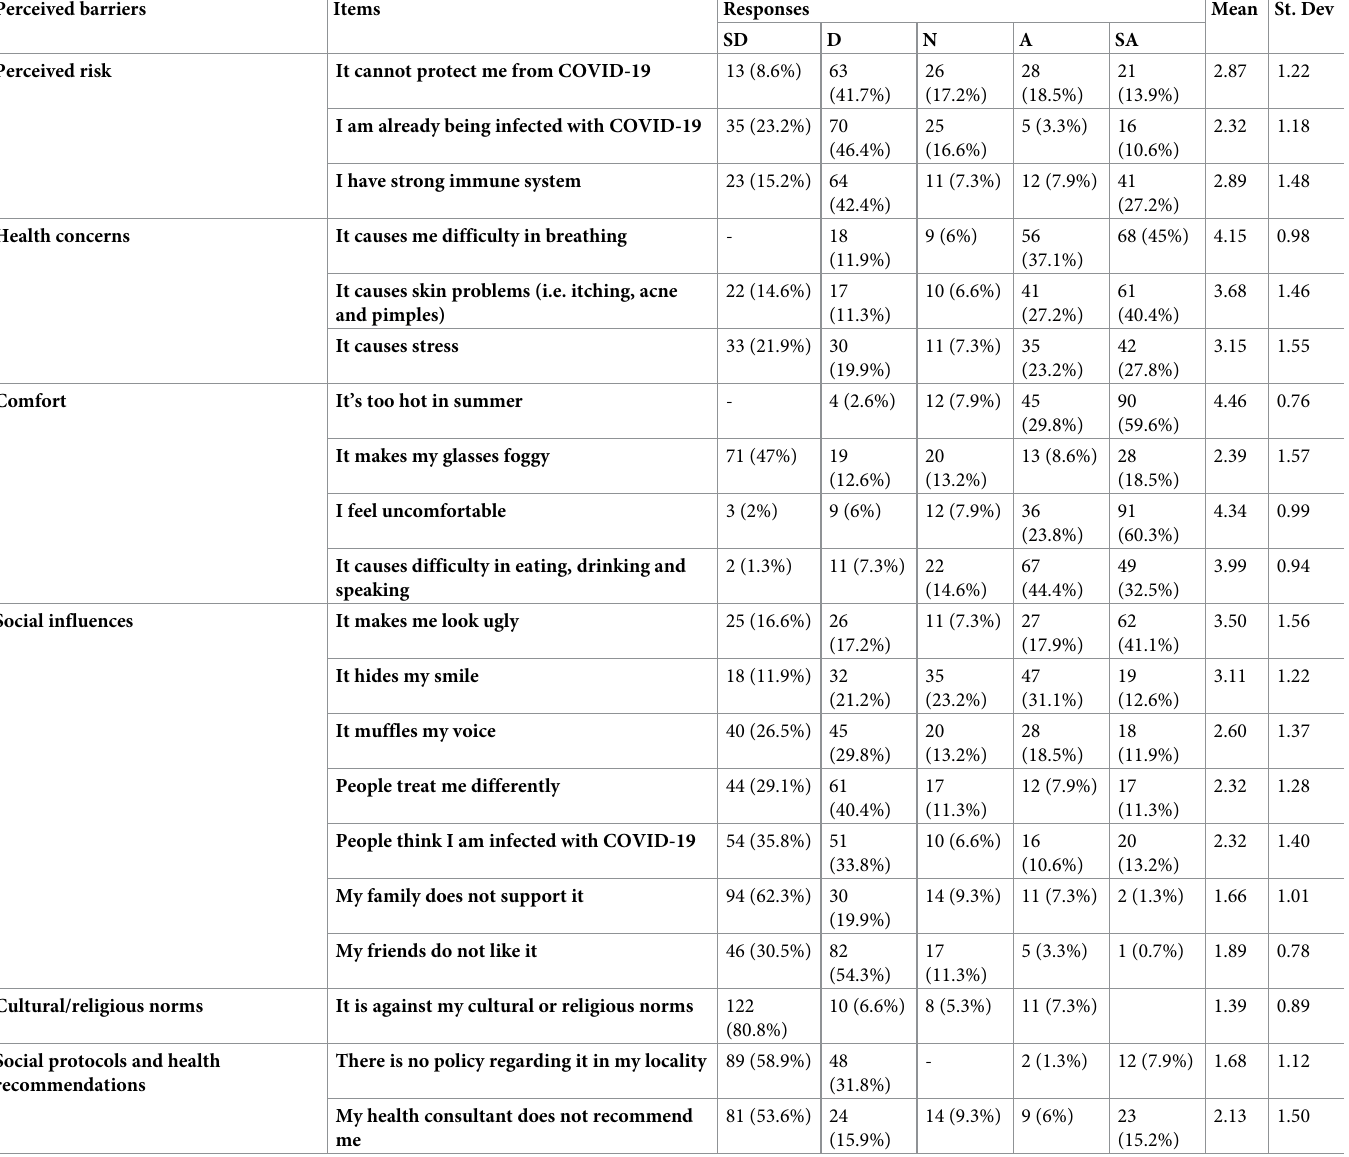
Table 2. Descriptive statistics of perceived barriers to wearing face masks. Perceived